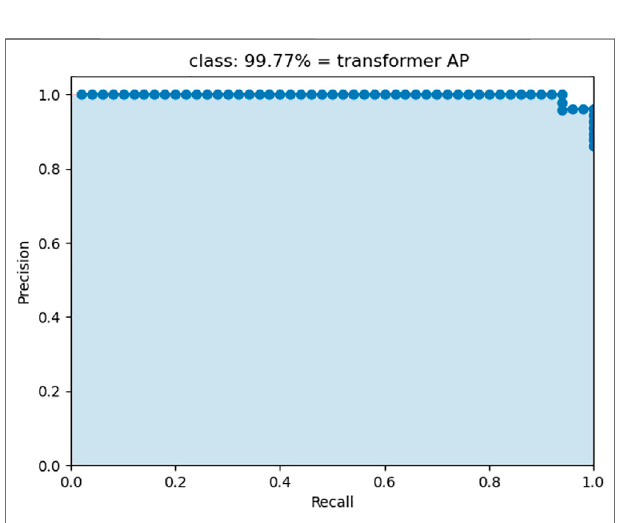
FIGURE 7 | AP curve of transformer test set.